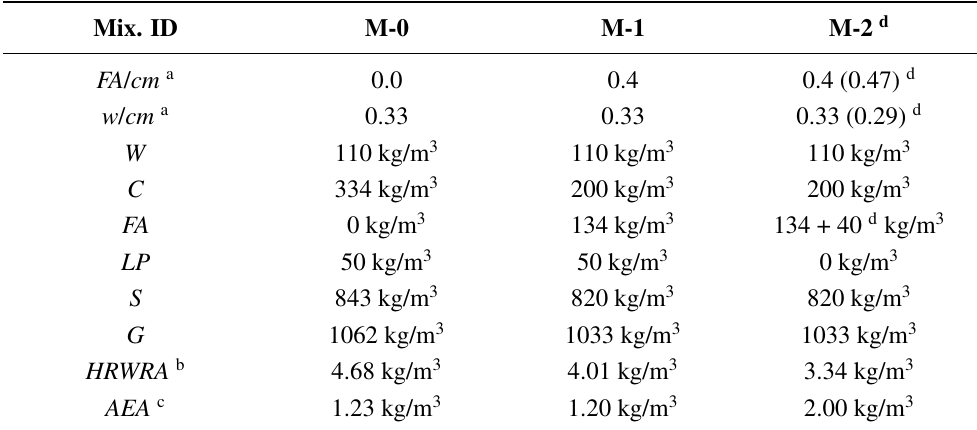
Table 4. Mixture proportions of